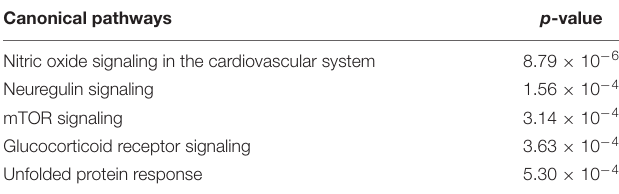
TABLE 4 | Top five canonical pathways with shared genes affected by DAP knockdown in proliferating and differentiating satellite cells based on p -value. Canonical pathways p